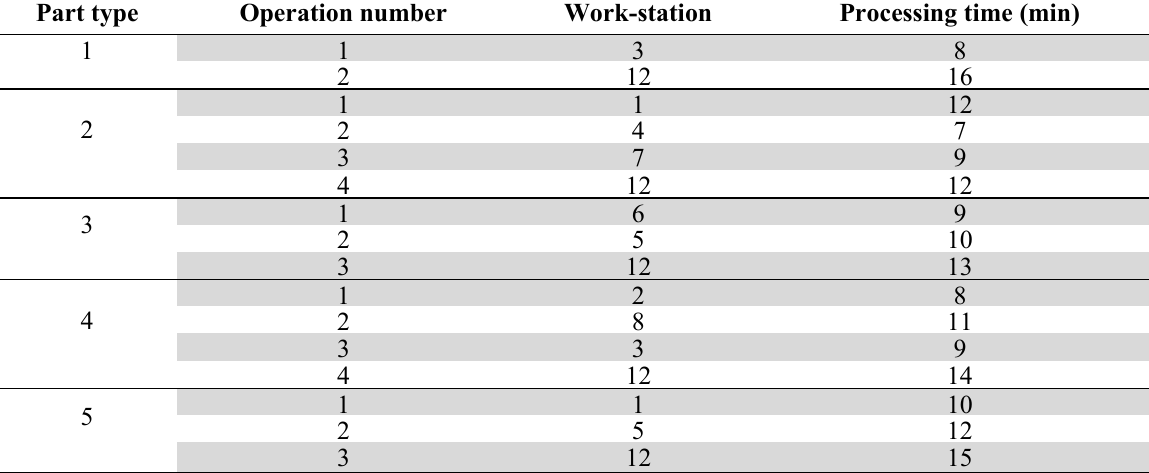
Part type routing & manufacturing characteristics for the FMS layout 4 Part type Operation number Work-station Processing time